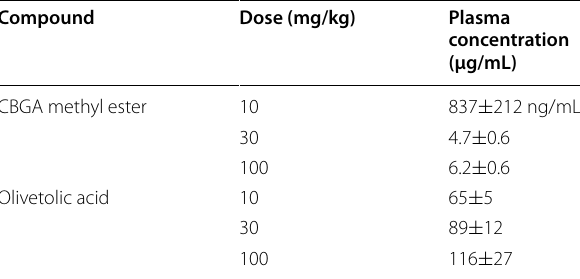
Table 2 Plasma concentrations of compounds in experimental Scn1a + ‑